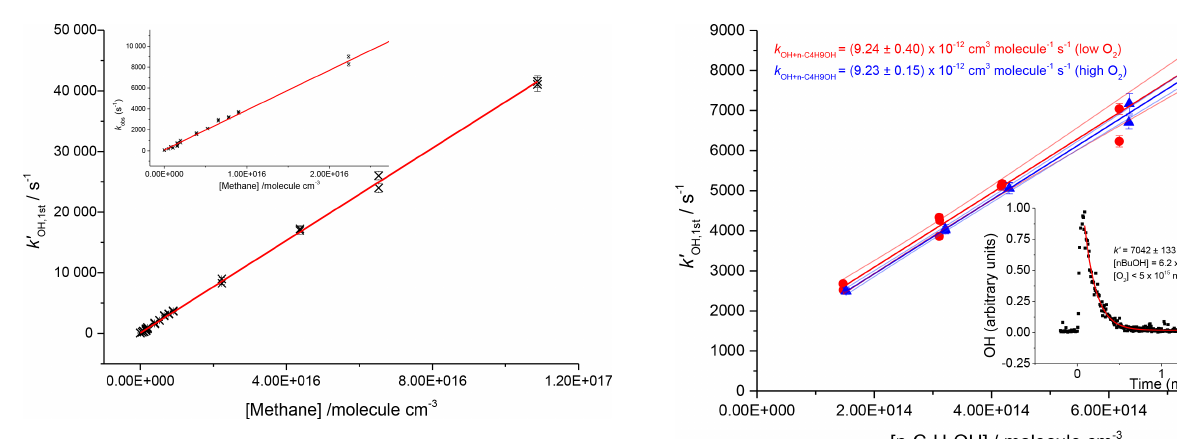
Figure 8. Bimolecular plot for the reaction of OH and methane at 680K and 1760Torr using 193nm photolysis of water as an OH precursor. Here the inset shows that even at removal rates < 1000s − 1 the plot is still linear, indicating that within the mea- sured experimental timescales there is little deviation in tempera- ture.